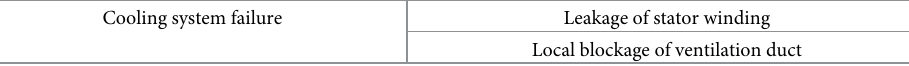
Table 10. Fuzzy comprehensive evaluation analysis.